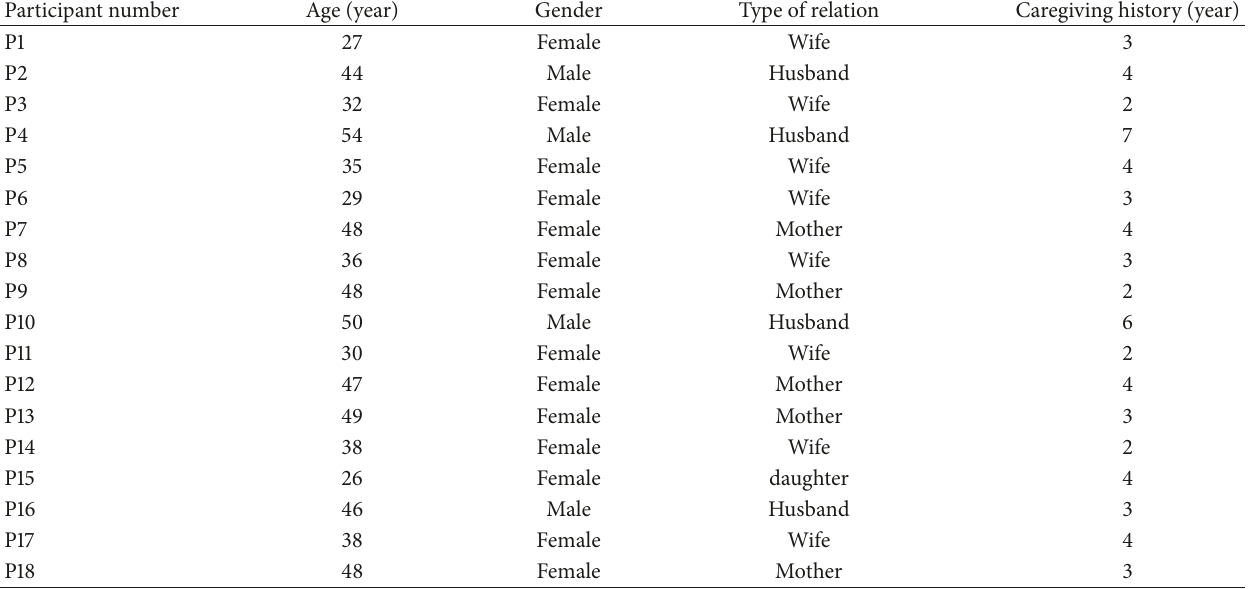
Table 1: Demographic characteristics of the study